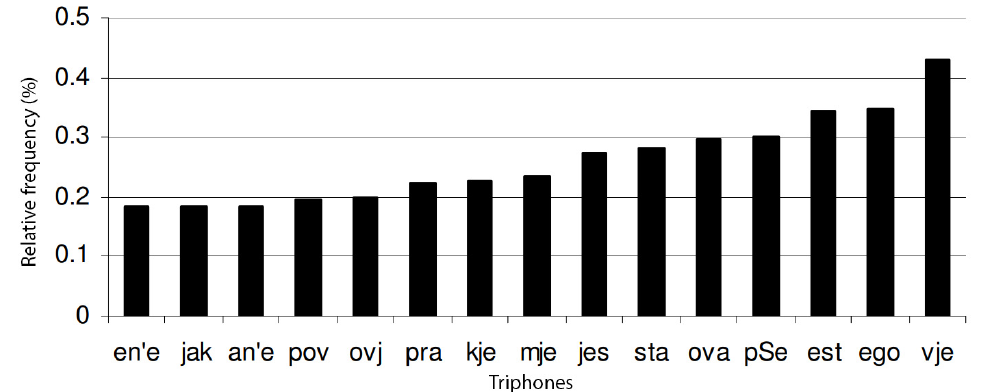
Figure 4. The 15 most common triphones. They account for 4.09% of all triphones in the final